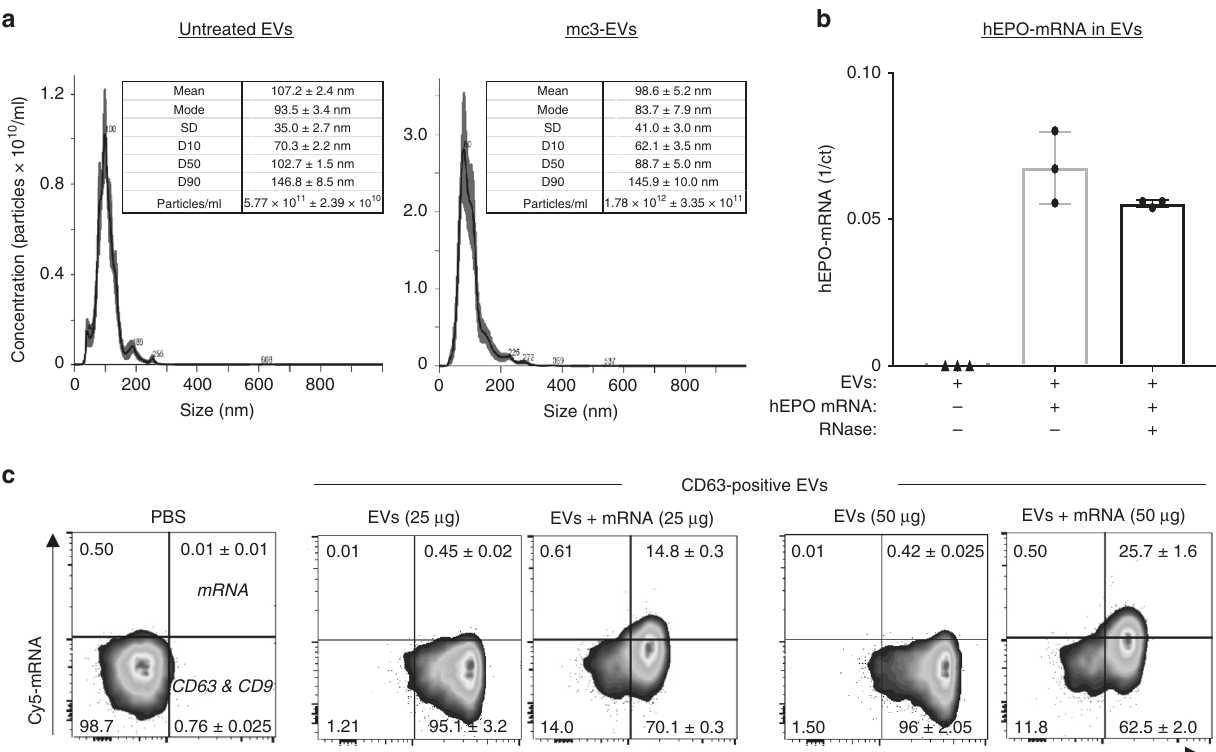
Fig. 2 Characterization of endo-EVs derived from LNP-treated cells. a Nanoparticle tracking analysis for size distribution and concentration of EVs from untreated cells (Left side panel) and from MC3-LNP-treated cells (Right side panel). For each graph (one representative replicate), a table is provided, including mean and mode sizes, SD, and D -values (D10, D50, D90) and particle concentration. b EV-mRNA protection assay against RNase A. The hEPO- mRNA qPCR data is represented as scatter dot plot and mean SD of n = 3 biologically independent samples. c Cy5 mRNA in CD63/CD9 positive EVs. CD63 + EVs were stained against CD9 antibody and analyzed by FACS for Cy5 mRNA detection. The sole beads incubated with PBS instead of EVs are shown as negative control. Approximately 96% of immunoprecipitated EVs (50 µ g assay) from untreated cells are positive for CD63 and CD9 but they are negative for mRNA. By contrast, ~88% of immunoprecipated EVs (50 µ g assay) from LNP-treated cells are positive for CD63 and CD9, and 26% EVs contain mRNA that is secreted after the endocytosis of LNP-mRNA. The percentage of CD63/CD9 positive EVs containing Cy5 mRNA is presented in the upper right quadrant. The FACS dot plots represent Cy5 mRNA ( y -axis) vs. CD9 ( x -axis). One out of two biological replicates is shown. Source data are provided as a Source Data fi